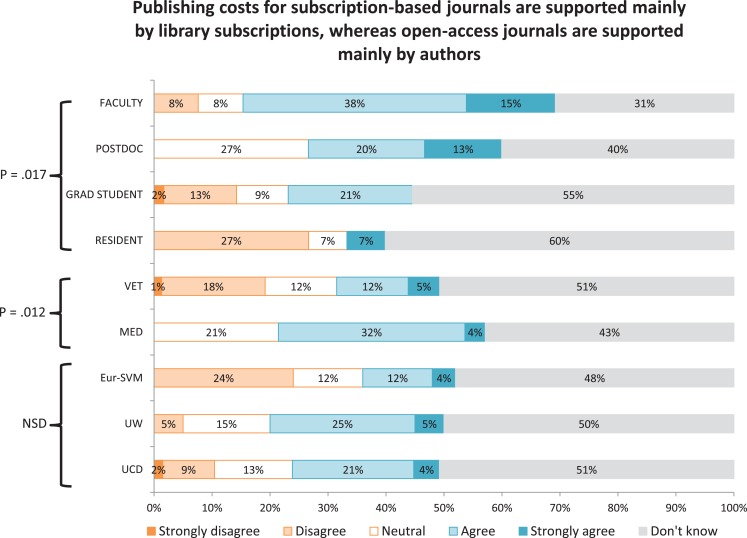
Differences in levels of agreement based on role, veterinary vs medical audience, and site for survey statement #12.